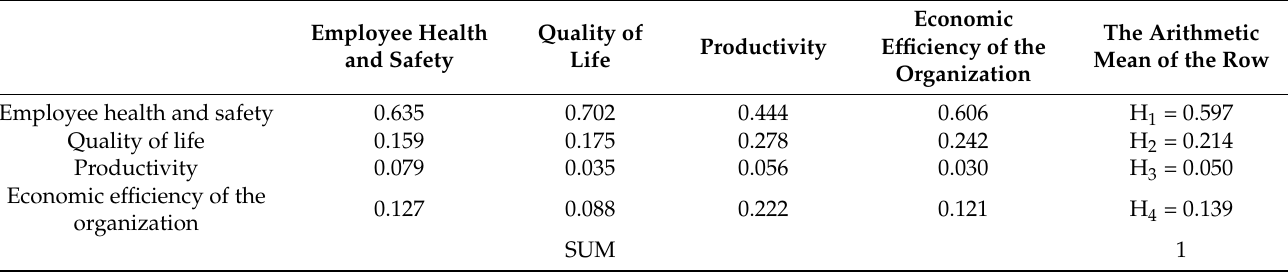
Table 4. Hierarchical synthesis with arithmetic averages